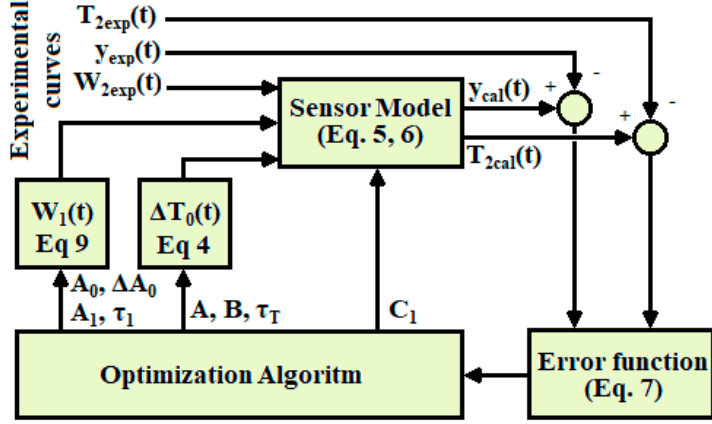
Figure 9. Heat capacity and heat flux calculation procedure.